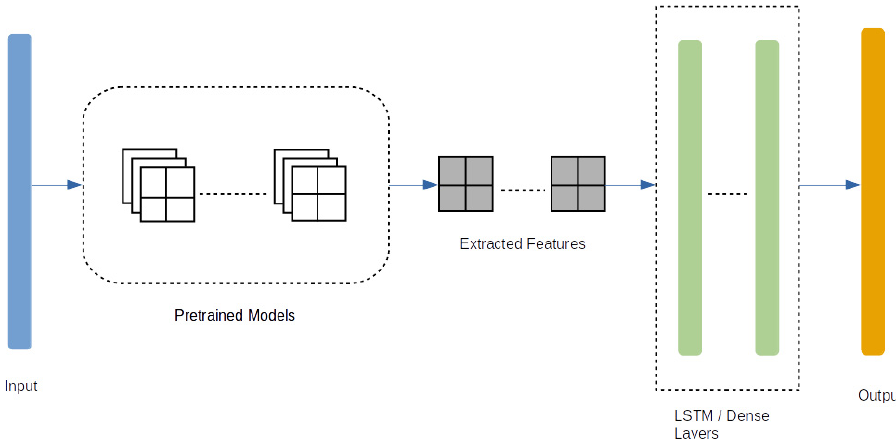
Fig. 2. A work°ow of the pretrained feature extraction and feeding to dense layers.